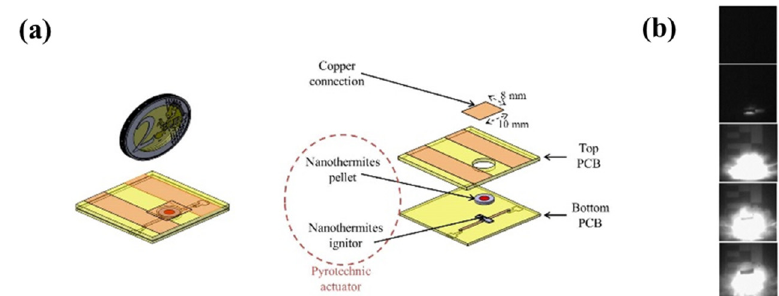
Figure 5. ( a ) 3D schematic of the nanothermite-based circuit breaker with exploded views and ( b ) snapshots of high speed images taken for the tested circuit breaker. The time between each picture is 100 µs. Taken from [15].